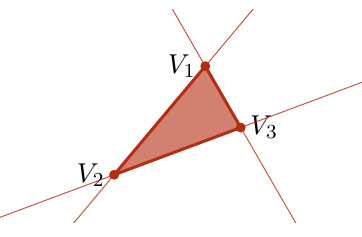
Figure 1 . Example of a 2 -simplex. The thick line segments and points refers to its 1 - and 0 -faces. When viewed in R 2 the thin lines are real lines and the 1 -faces are their segments, which are fixed. When viewed in CP 2 instead, the thin lines represent CP 1 subspaces that are determined by the 0 -faces, and each 1 -face is some real contour that can be deformed within the corresponding CP 1